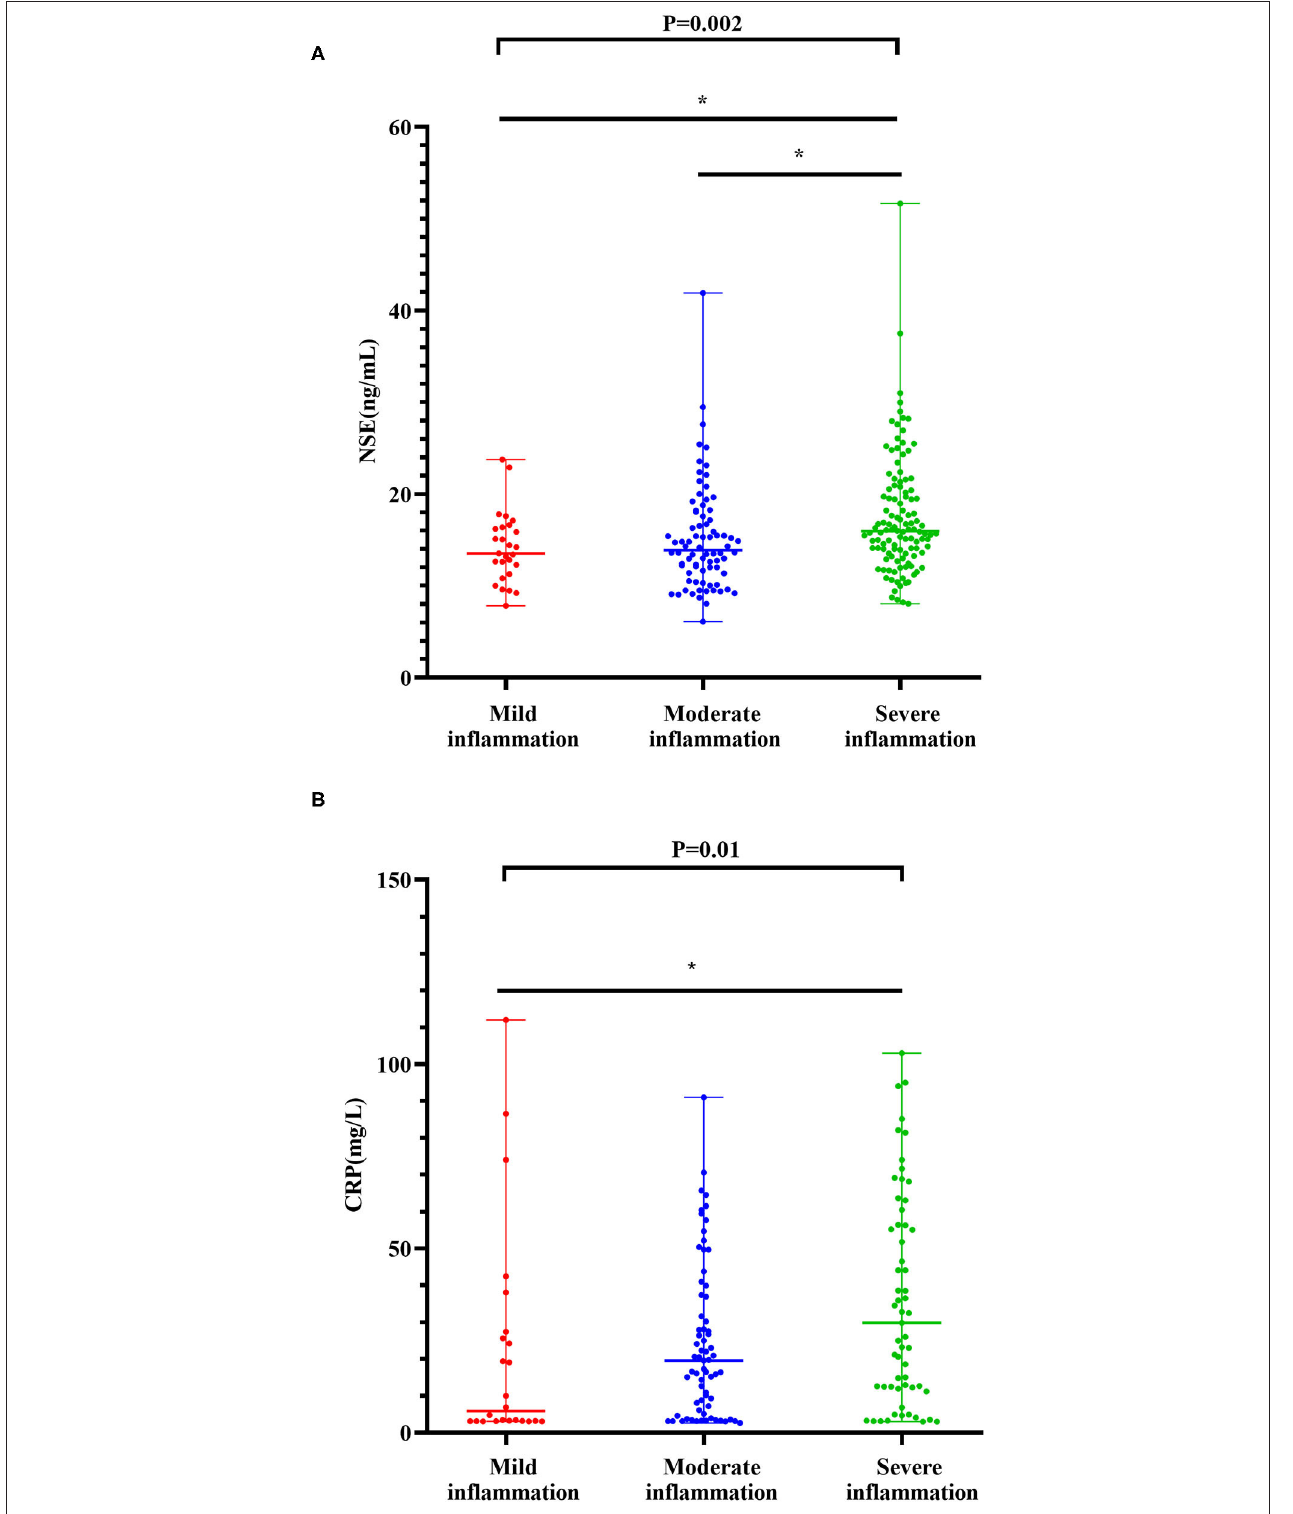
FIGURE 2 | Levels of NSE with degrees of inflammation in the CD cohort (A) . Levels of CRP with degrees of inflammation in the CD cohort (B) . The boxplots show median, upper, and lower quartiles of the data; the whiskers indicate the 95% confidence interval of the values (* P < 0.05 and ** P < 0.001).